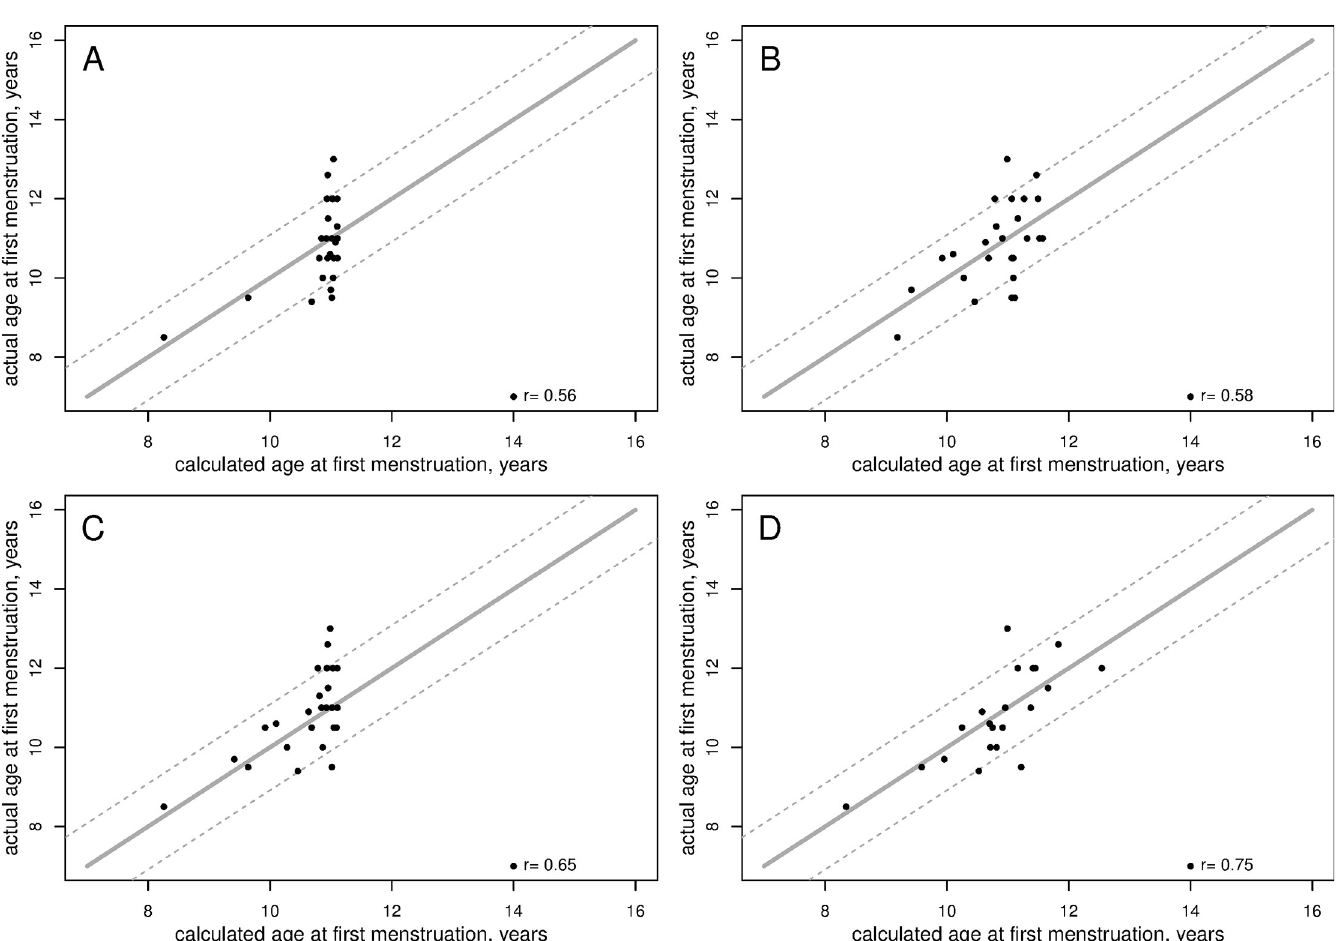
Fig 3. Correlations between the actual and calculated ages at first menstruation in 25 girls with untreated CPP. Ages are calculated using (A) serum inhibin B concentrations (formula 1); or (B) LH/FSH peak ratio (formula 2); (C) the lowest of the two predictions (formula 3); or (D) the non-linear model (formula 4). Each dot is one girl. Dot-lines correspond to ± 1 SD (1.09 years). Models are available online at: http://www.kamick.org/lemaire/med/girls-cpp18.html.